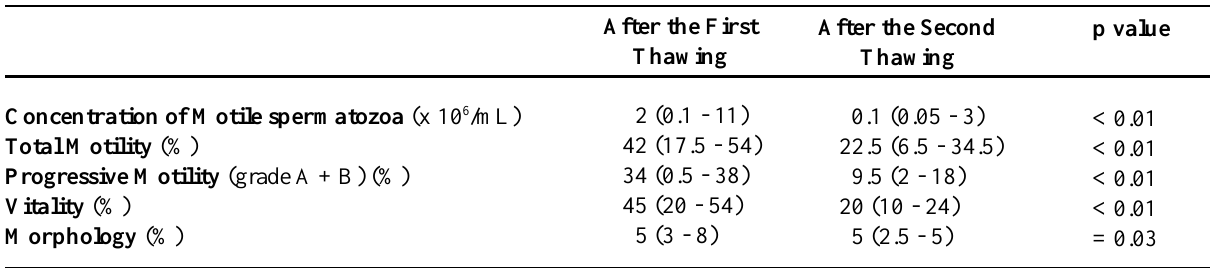
Table 1 – Assessment of spermatic parameters after the first and the second thawing of 20 seminal samples. The values are expressed as median and 25 and 75 percentiles.